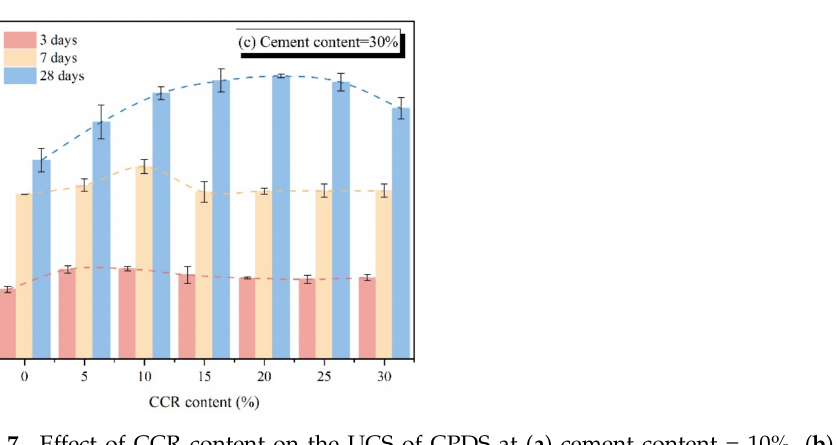
Figure 7. Effect of CCR content on the UCS of CPDS at ( a ) cement content = 10%, ( b ) cement content = 20% and ( c ) cement content = 30%.